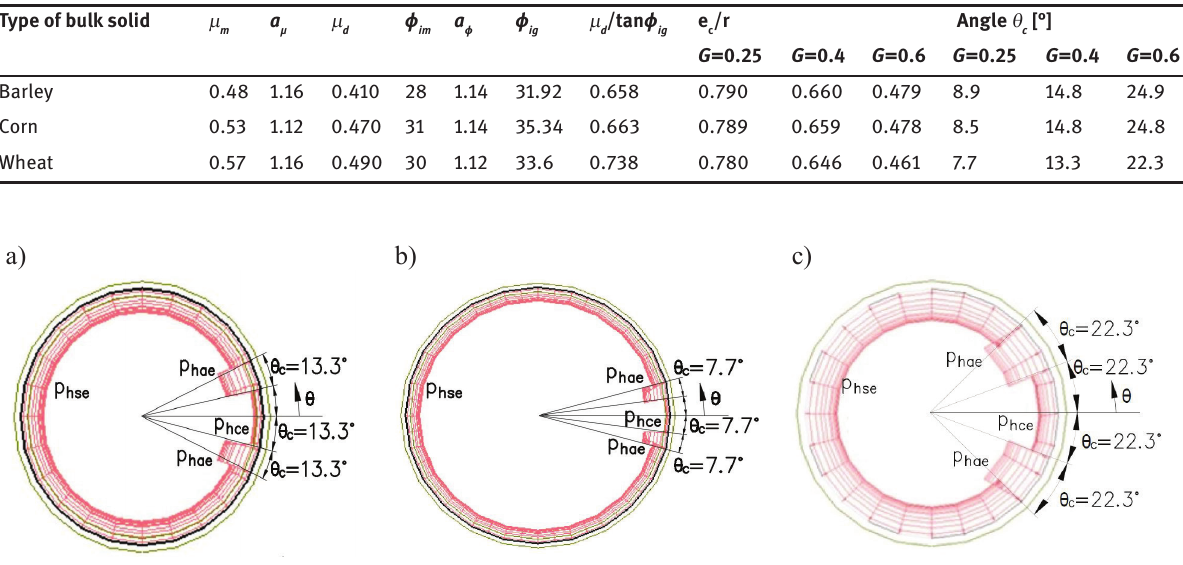
Table 2: Parameters specifying the geometry of the flow channel (AAC3 class) for the selected bulk solids for reinforced concrete silo wall (D3 wall category, according to Eurocode 1, Part 4